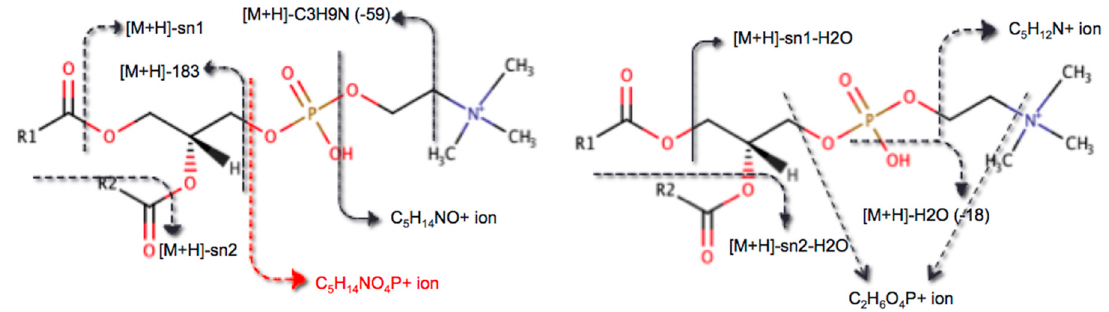
Figure 1. Fragmentation patterns of phosphatidylcholines obtained from their [M+H] + precursor ions. Among all resulting fragments, only the precursor ion is observed at each of the three energy levels. The ion fragment C 5 H 14 NO 4 P + (red arrow) corresponding to phosphocholine is observed at 20 and 40 eV, and the remaining fragments were observed only at 40 eV. Table 1. Number of fragmentation rules and adduct types covered for each chemical category.